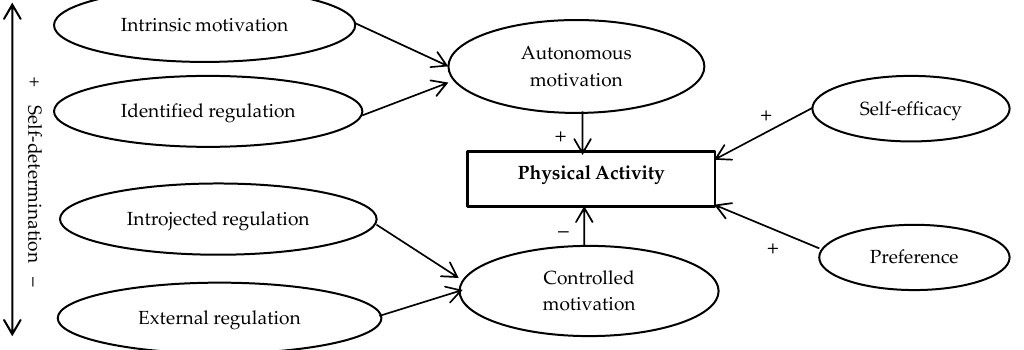
Figure 1. Hypothesis of study psychological correlates and physical activity behaviors.